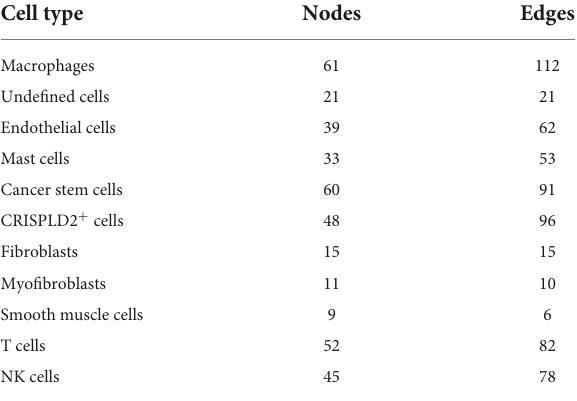
TABLE 2 The numbers of nodes and relation pairs (edges) in the PPI network of each cell